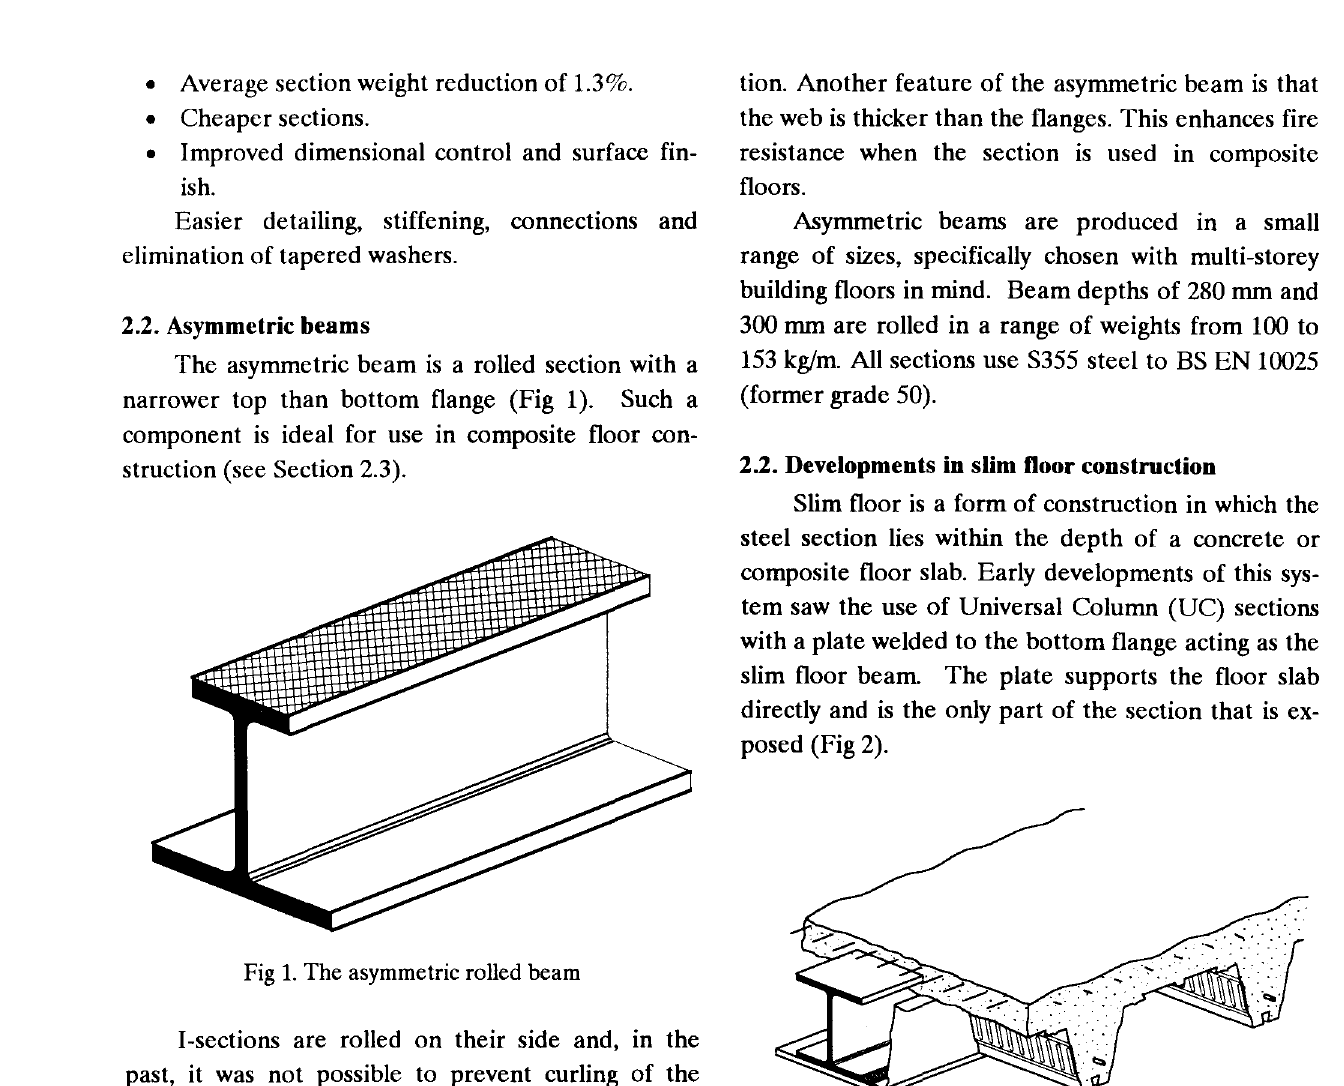
Fig 1. The asymmetric rolled beam